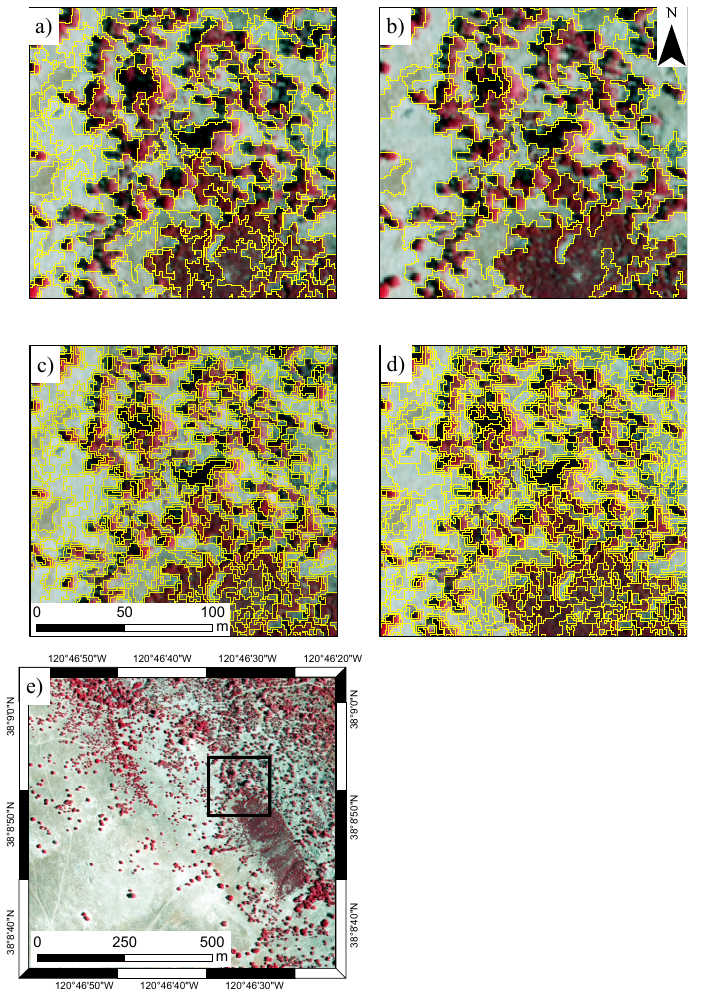
Figure 4. A comparison of segmentation results (yellow outline) using different packages applied to a test dataset of near-infrared aerial photography over wooded savanna in California, U.S. Results shown for a subset segmented using ( a ) RSGISLib, ( b ) OTB, ( c ) InterIMAGE and ( d ) eCognition. The full image is shown in ( e